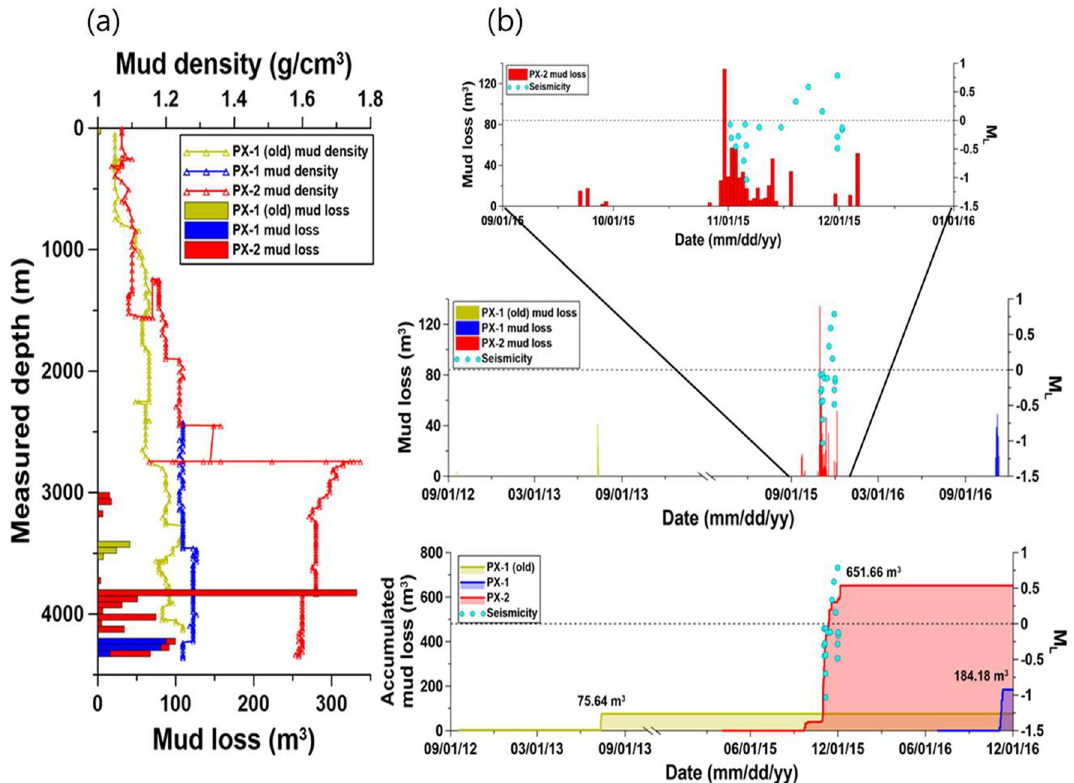
Figure 2. ( a ) Volume of mud loss and mud density of the PX-1 (old), PX-1, and PX-2 wells at specific depths during the drilling periods and ( b ) the temporal distribution of accumulated mud loss and